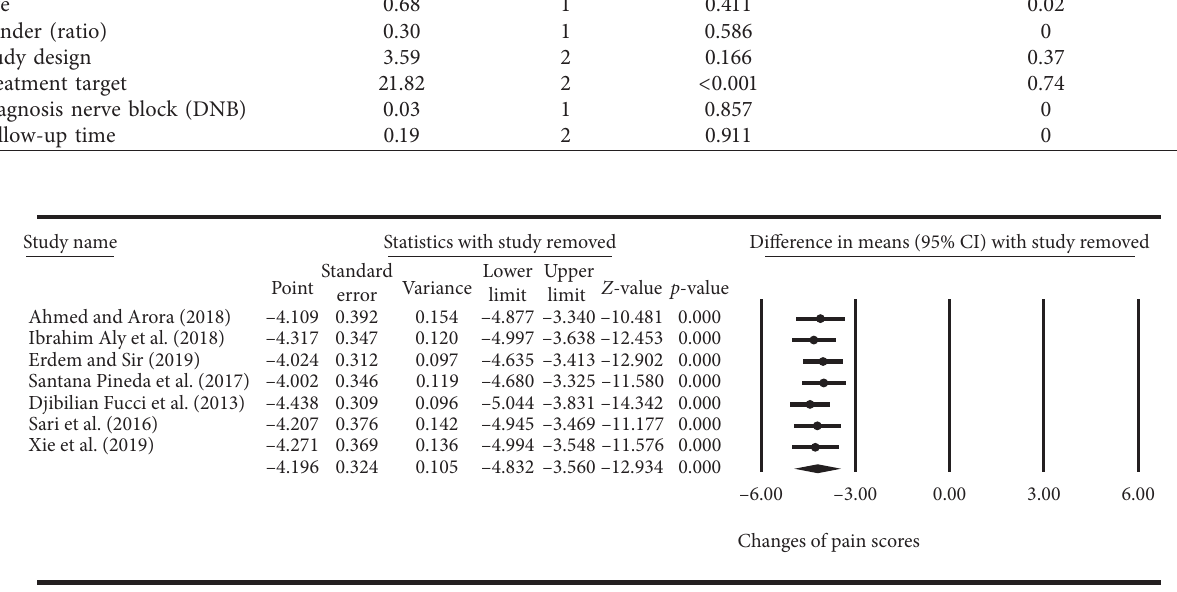
Figure 7: Effect of ultrasound-guided radiofrequency (RF) on pain scores by sensitivity